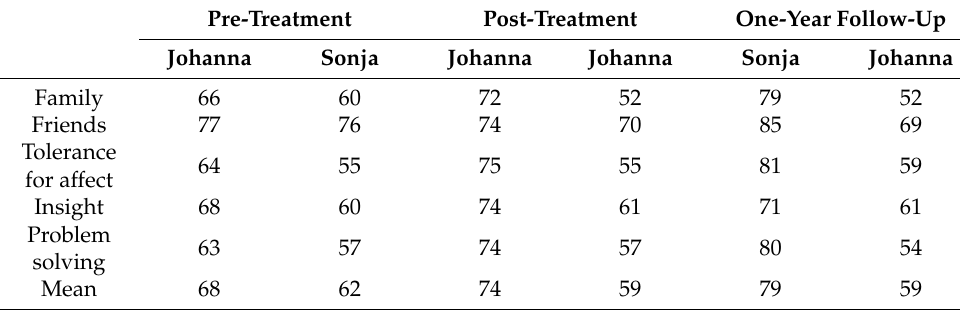
Table 2. PFS scores for Johanna and Sonja at three time points. Pre-Treatment Post-Treatment One-Year Follow-Up